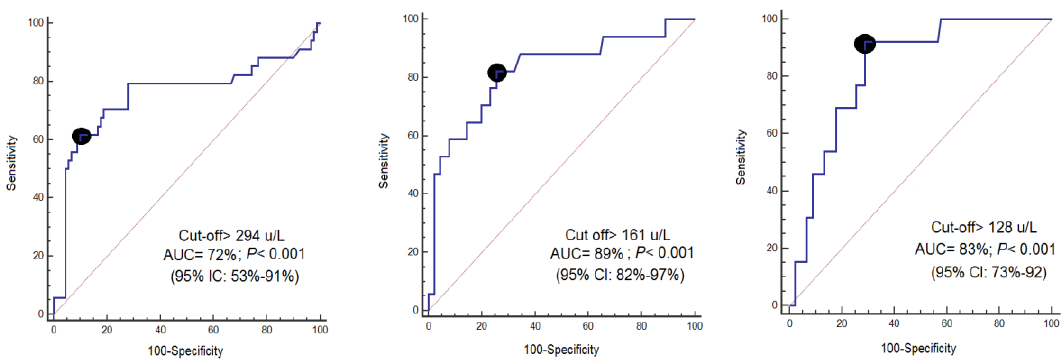
Figure 2. Receiver operation characteristic analysis using serum caspase-cleaved cytokeratin (CCCK)-18 levels on day 1, day 4, and day 8 after trauma brain injury as predictor of mortality at 30 days.